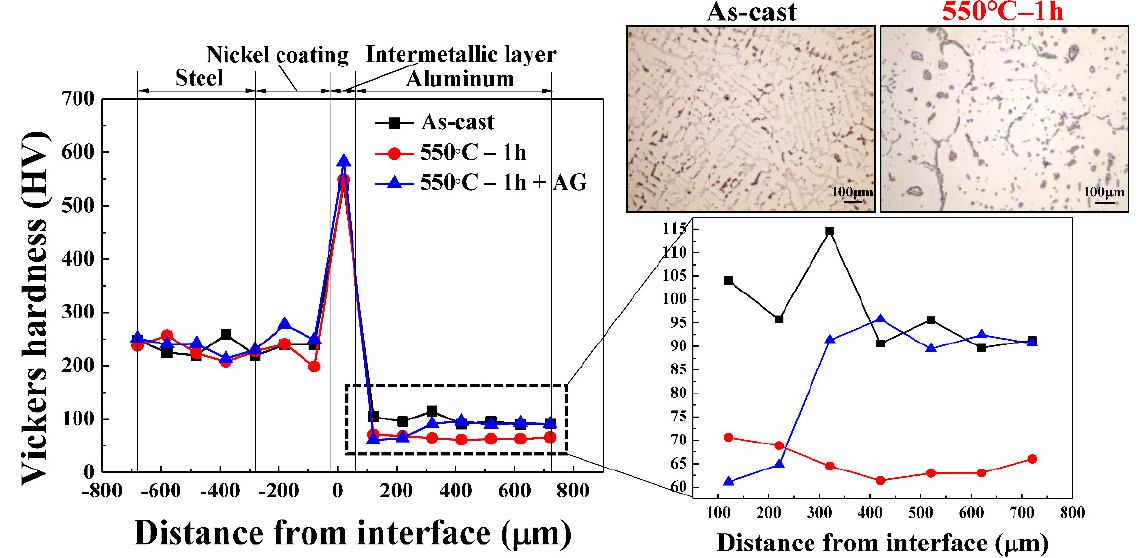
Figure 9. Micro-hardness distribution across the Al/Fe alloys hybrid structure’s interface under as-cast and heat treatment conditions; AG: Artificial aging.